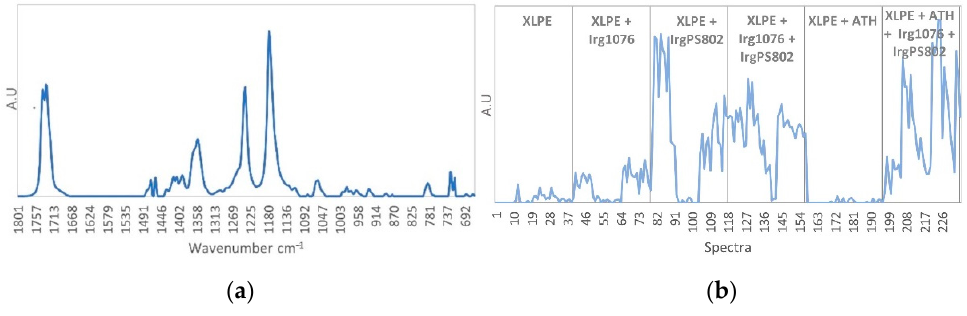
Figure 12. ( a ) IrgPS802 pure spectrum. ( b ) IrgPS802 concentration profile. The third pure spectrum (Figure 13a) corresponds to Irganox PS802 degradation products, the characteristic infrared band are found at 1735 cm − 1 , 1463 cm − 1 , 1419 cm − 1 , 1363 cm − 1 , 1311 cm − 1 , 1263 cm − 1 , 1186 cm − 1 , 1128 cm − 1 , 1056 cm − 1 , 989 cm − 1 , 788 cm − 1 728 cm − 1 . The concentration profile (Figure 13b) shows an important contribution for spectra 91 to 102 which correspond to the high degradation of Irganox PS802 from the dose 145 to 374 kGy at 40 Gy/h (spectra 91 to 102) shown in Figure 13. Other important contributions were shown for spectra 130 to 141 and 208 to 219 corresponding to the samples irradiated at 40 Gy/h, from the dose 145 to 374 kGy for which the Irganox PS802 consumption was also observed in Figure 13.